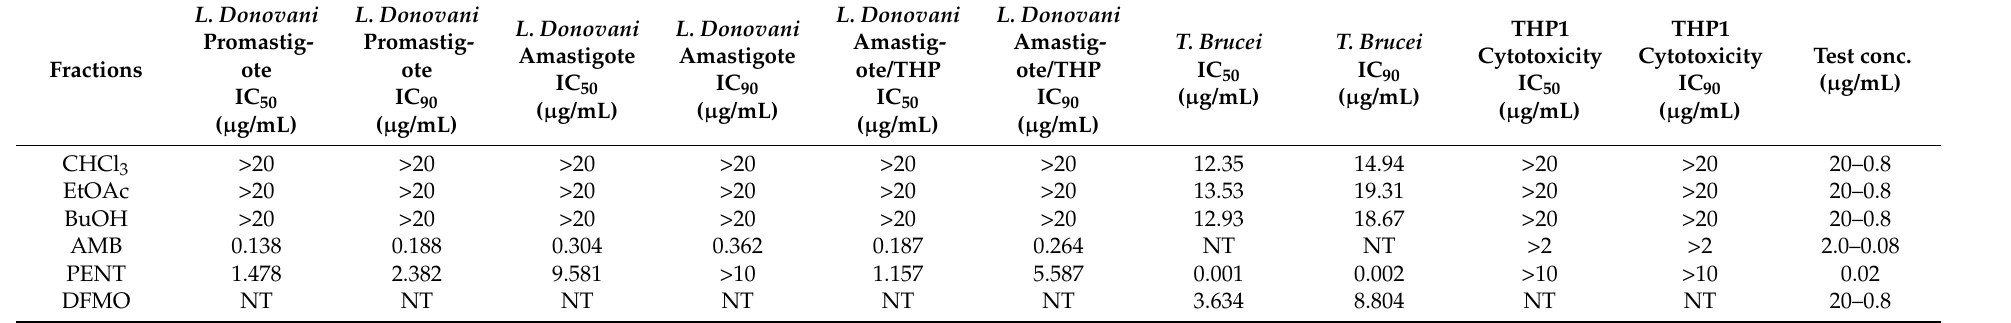
Table 2. Antiprotozoal activity and cytotoxicity of H. afrum